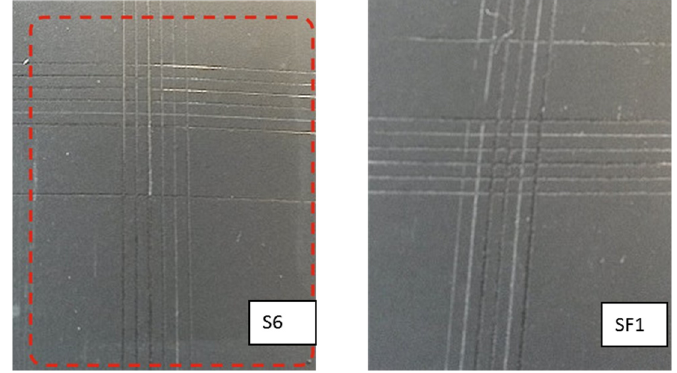
Figure 3. Comparison between S6 vs. SF1 coated panels after thermal treatment.